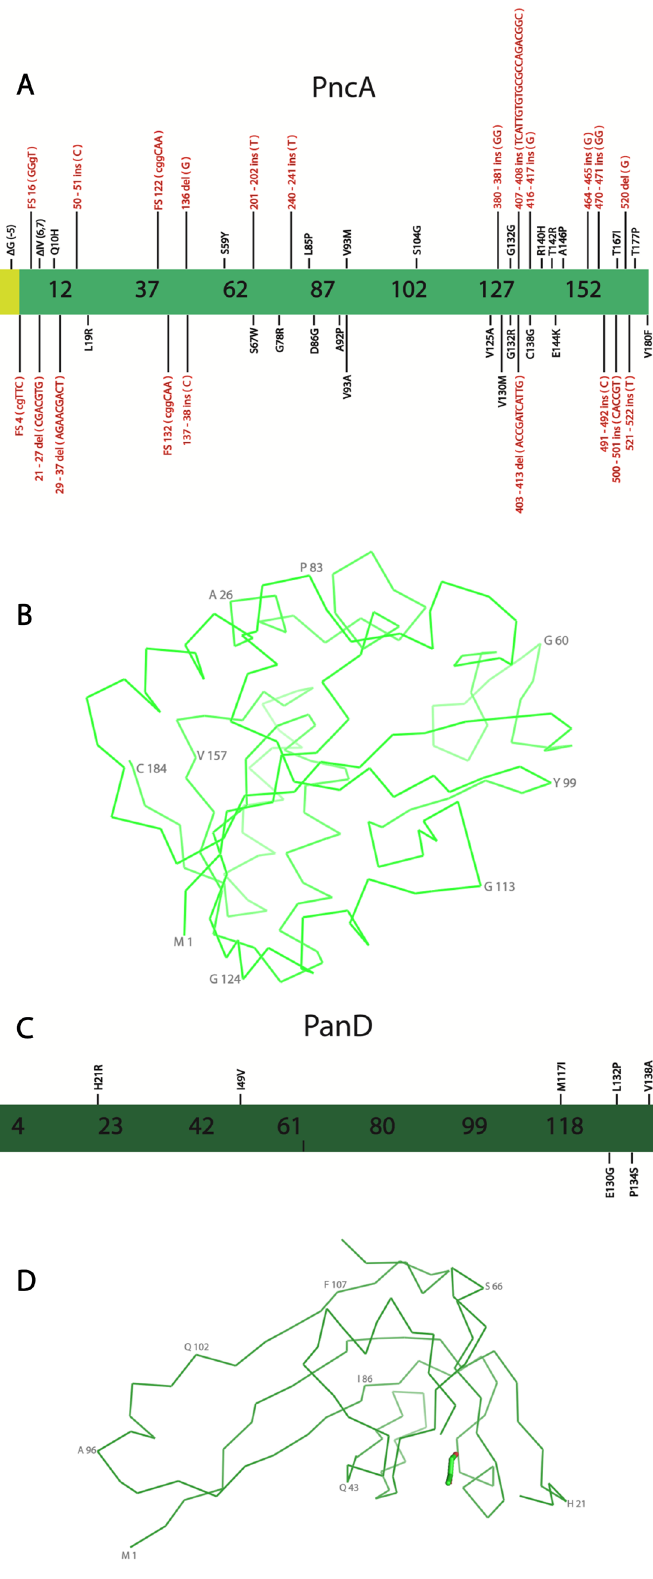
Figure 6 - Structure and relevant mutations for PncA and PanD, enzymes involved in PZA resistance. A – Representation of the PncA primary sequence in light green, showing key mutations. Substitutions are shown in black, while insertions and deletions are sown in red. The pncA promoter region is shown in yellow. B – Structure of PncA. The contours of Cα are shown in light green. PncA structure was obtained from PDB entry 3PL1 (Petrella et al ., 2011) and the figure was prepared using the software PyMOL (Schrödinger, 2015). Some residues are numbered in 50% opacity for better visualization. C - Representation of the PanD primary sequence is shown in dark green, highlighting the most significant mutations. D - PanD Structure. The contours of Cα are shown in dark green, while PZA is shown with carbon atoms in light green. The PanD Structure was obtained from PDB entry 6OZ8 (Sun et al ., 2020) and the figure was prepared using the software PyMOL (Schrödinger, 2015) . A number of residues are numbered in 50% opacity for better